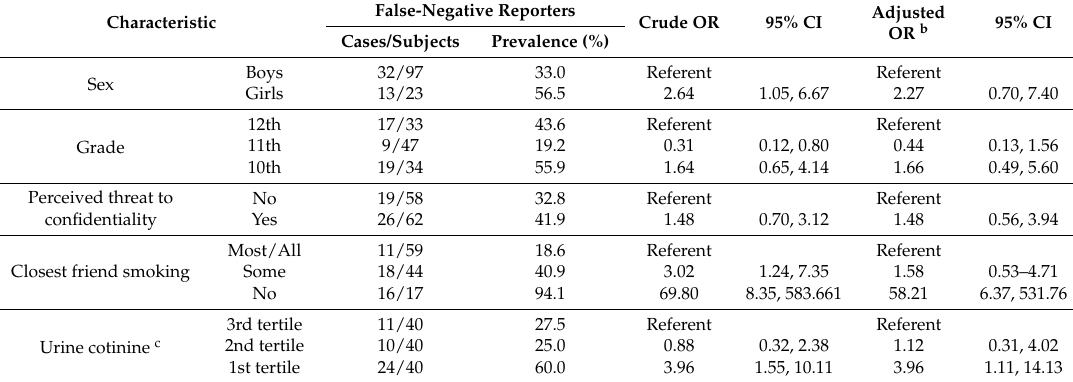
Table 4. Prevalence and adjusted odds ratios of false-negative reporters about smoking status according to characteristics in current smokers a